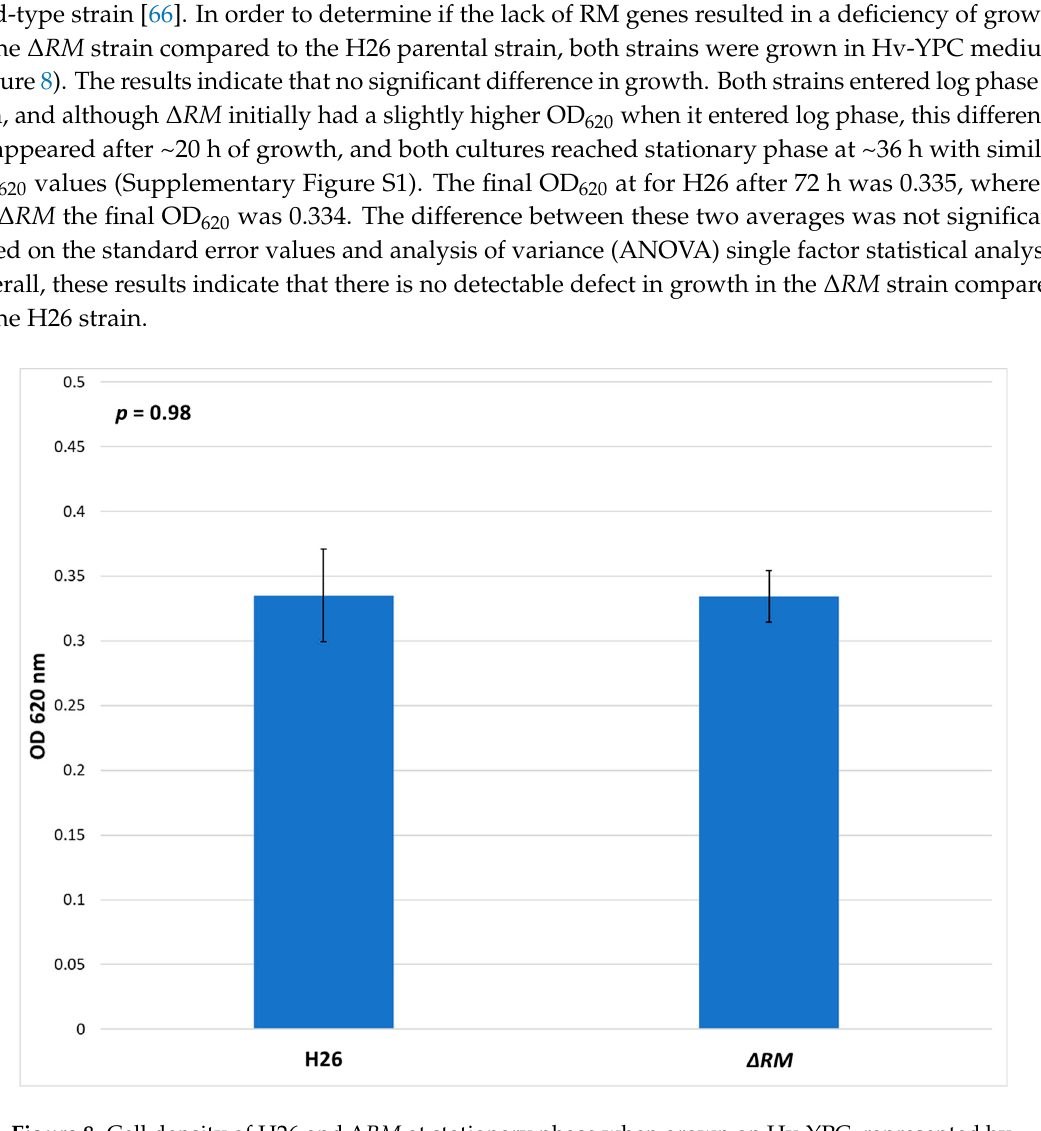
Figure 8. Cell density of H26 and Δ RM at stationary phase when grown on Hv-YPC, represented by the average optical density (OD 620 ) reading of 24 cell culture replicates after 72 hours of growth. Error bars indicate the standard error of the mean. Analysis of variance (ANOVA) single factor, p = 0.98.